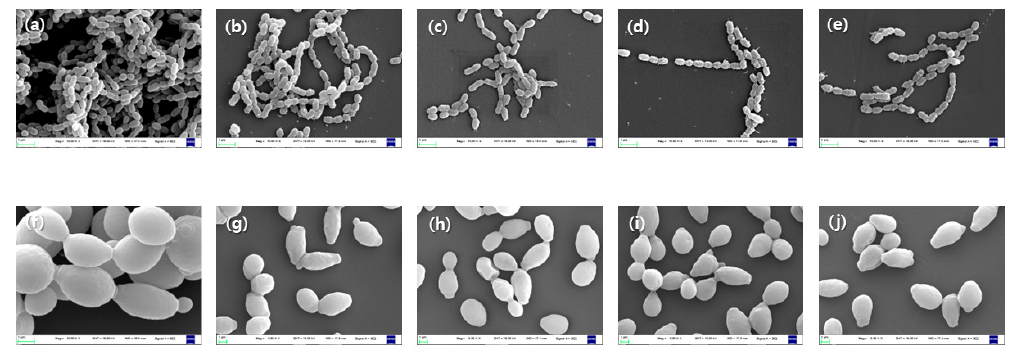
Figure 5. CFU results for S. mutans group ( a ) 0 μ g/mL ( b ) 50 μ g/mL ( c ) 100 μ g/mL ( d ) 150 μ g/mL ( e ) 200 μ g/mL); C. albicans group ( f ) 0 μ g/mL ( g ) 50 μ g/mL ( h ) 100 μ g/mL ( i ) 150 μ g/mL ( j ) 200 μ g/mL).